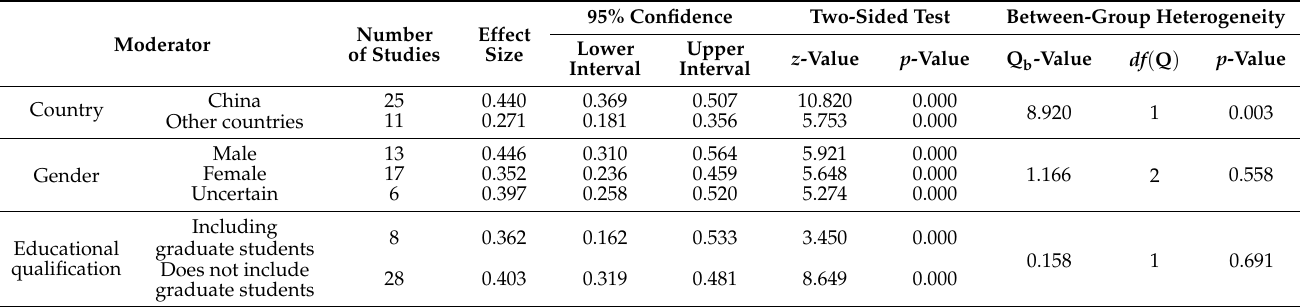
Table 3. Meta-analysis results of moderation effect